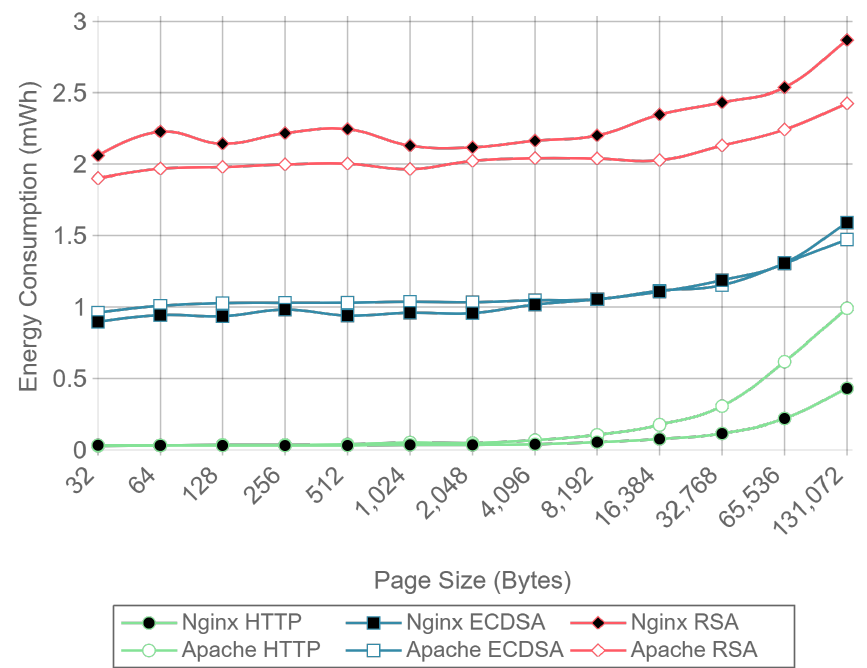
Figure 10. Server-side page size versus energy consumption for Apache2 and Nginx with two concurrent